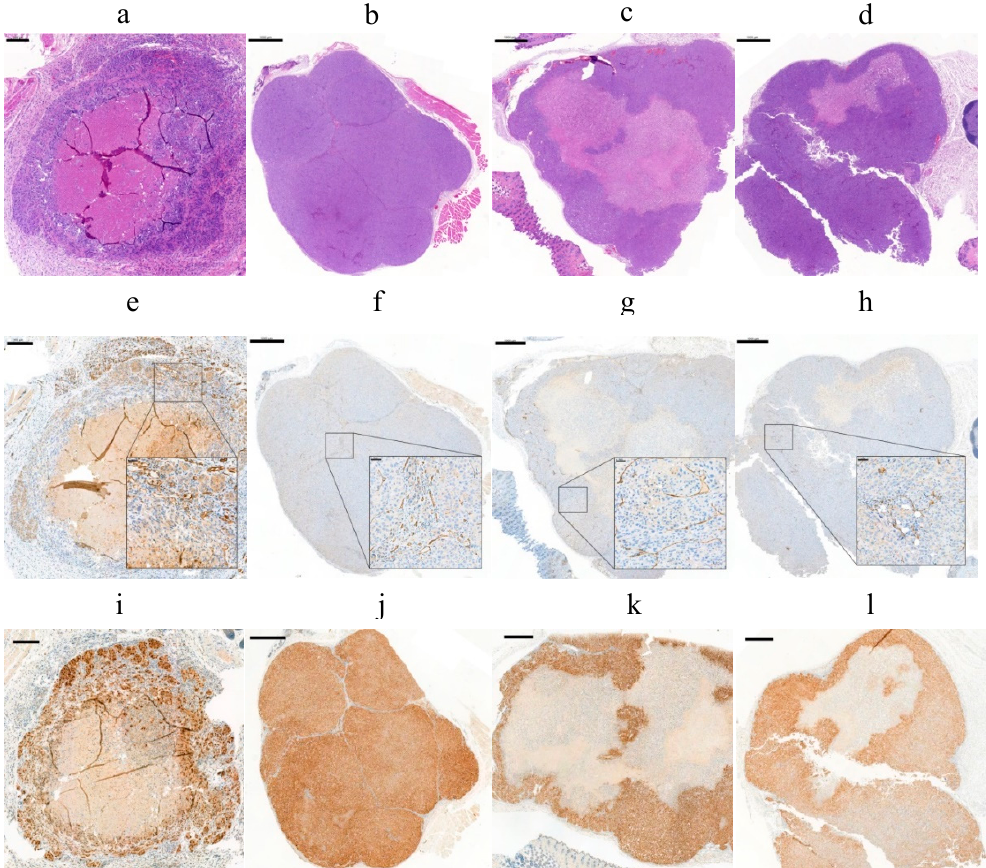
Figure 9. Evaluation of vascular density and hypoxia in FFPE from four different SK-RC-52 tumors: